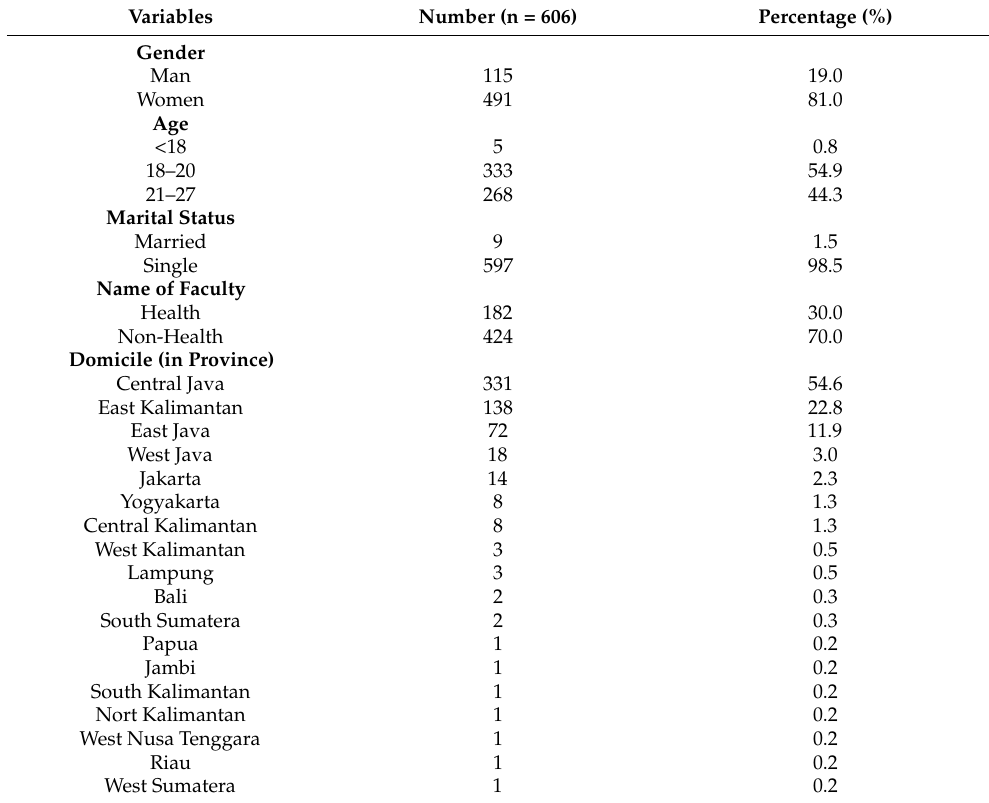
Table 1. Demographic characteristics of respondents (n = 606).